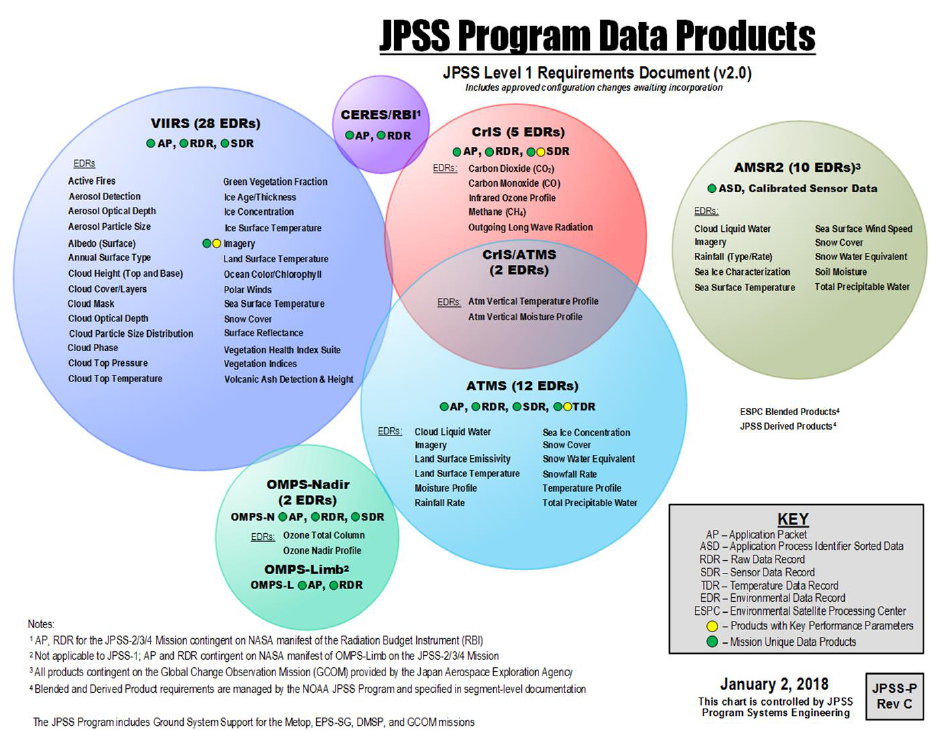
Figure 1. Sensor and Environmental Data (xDR) products from the S-NPP/NOAA-20/GCOM-W1 instruments suite [2]. The figure can be accessed from the JSTAR webpage: https://www.star.nesdis.noaa.gov/jpss/JSTAR.p.hp (accessed on 23 rd January 2023).